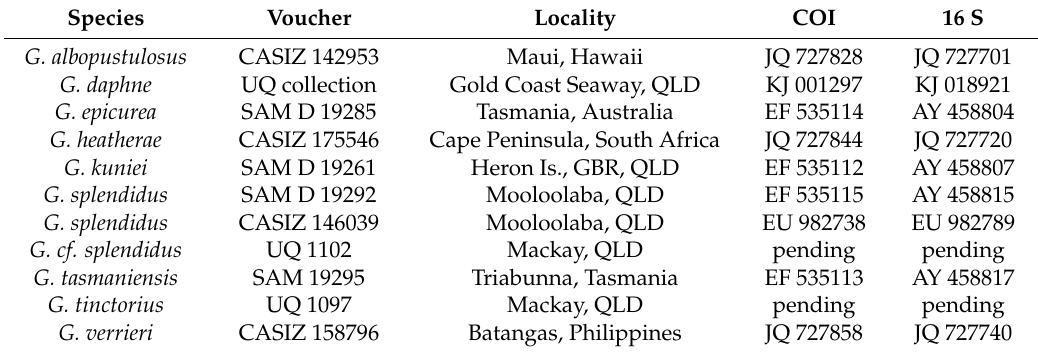
Table 1. Species of Goniobranchus included in the phylogenetic analysis.